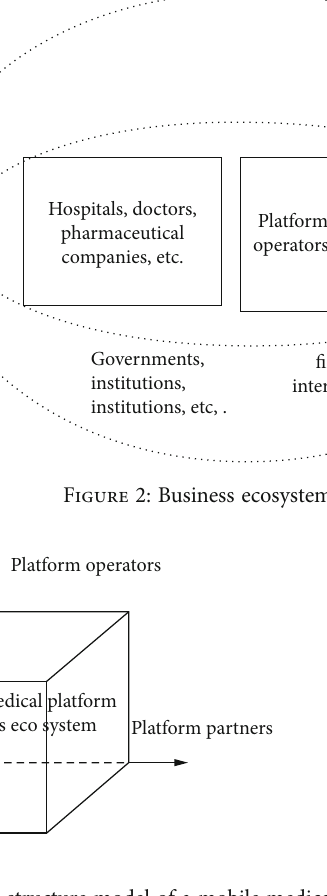
Figure 3: Three-dimensional structure model of a mobile medical platform business